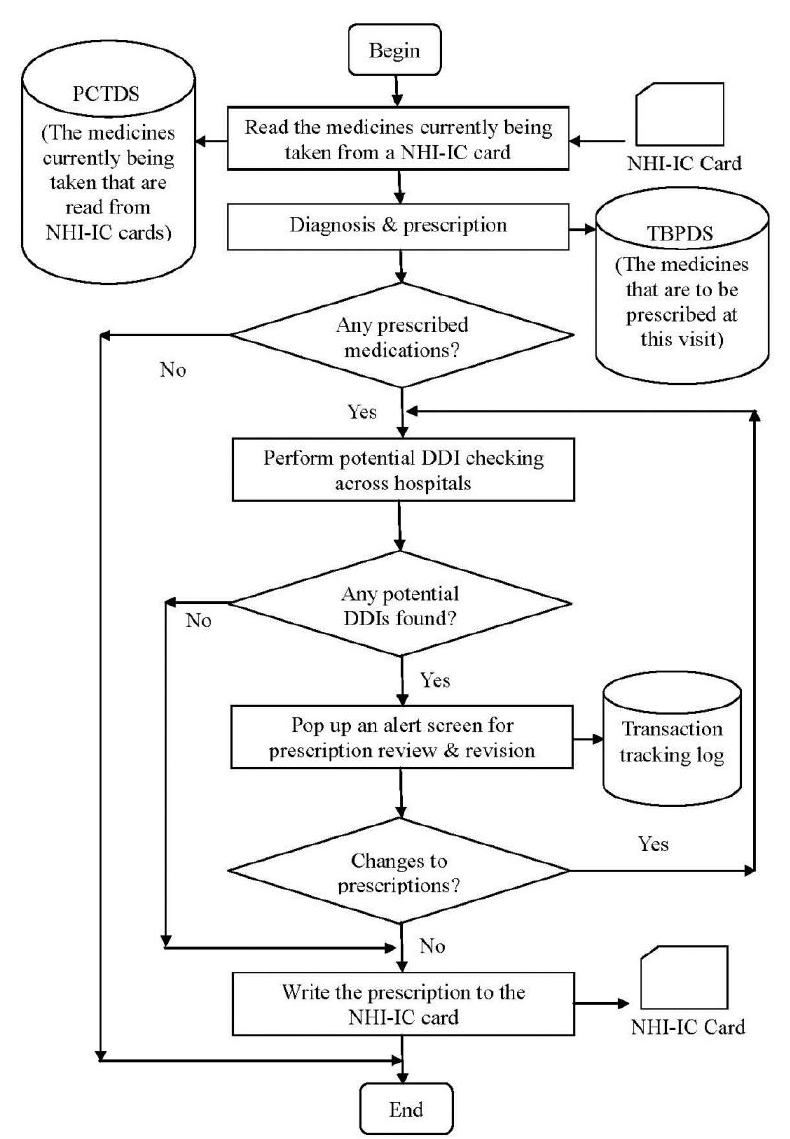
Figure 2. The workflow for detecting potential DDIs involving multiple